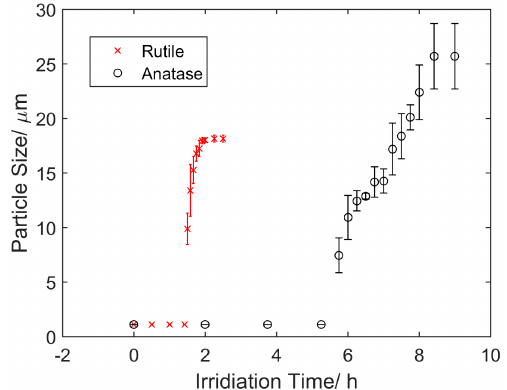
Figure 2. Size change of the rutile and anatase submicron particles in DI water as a function of irradiation time. The UV light was turned on at 0 h.